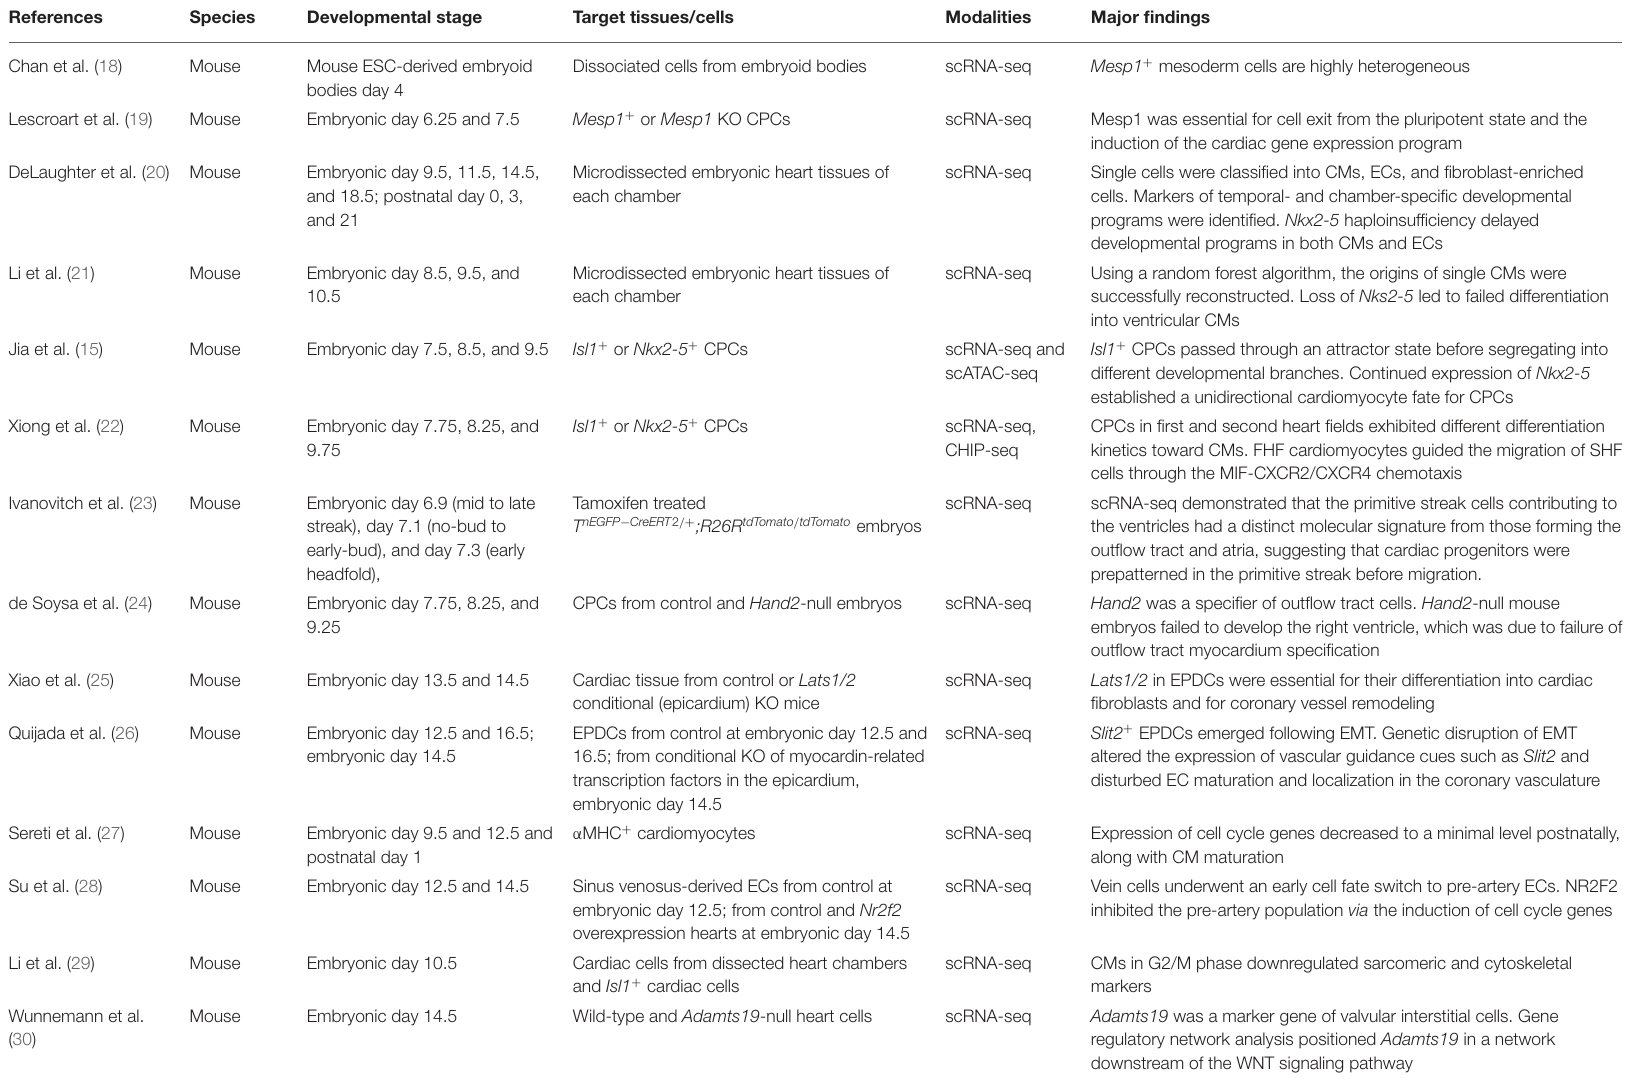
TABLE 1 | Summary of studies of heart